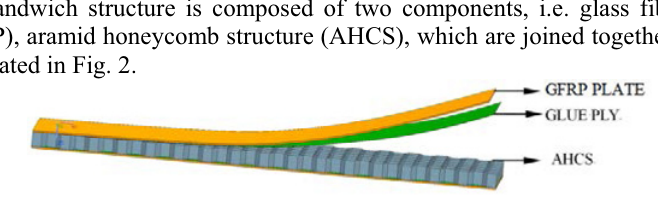
Fig. 2. Schematic diagram of the used sandwich